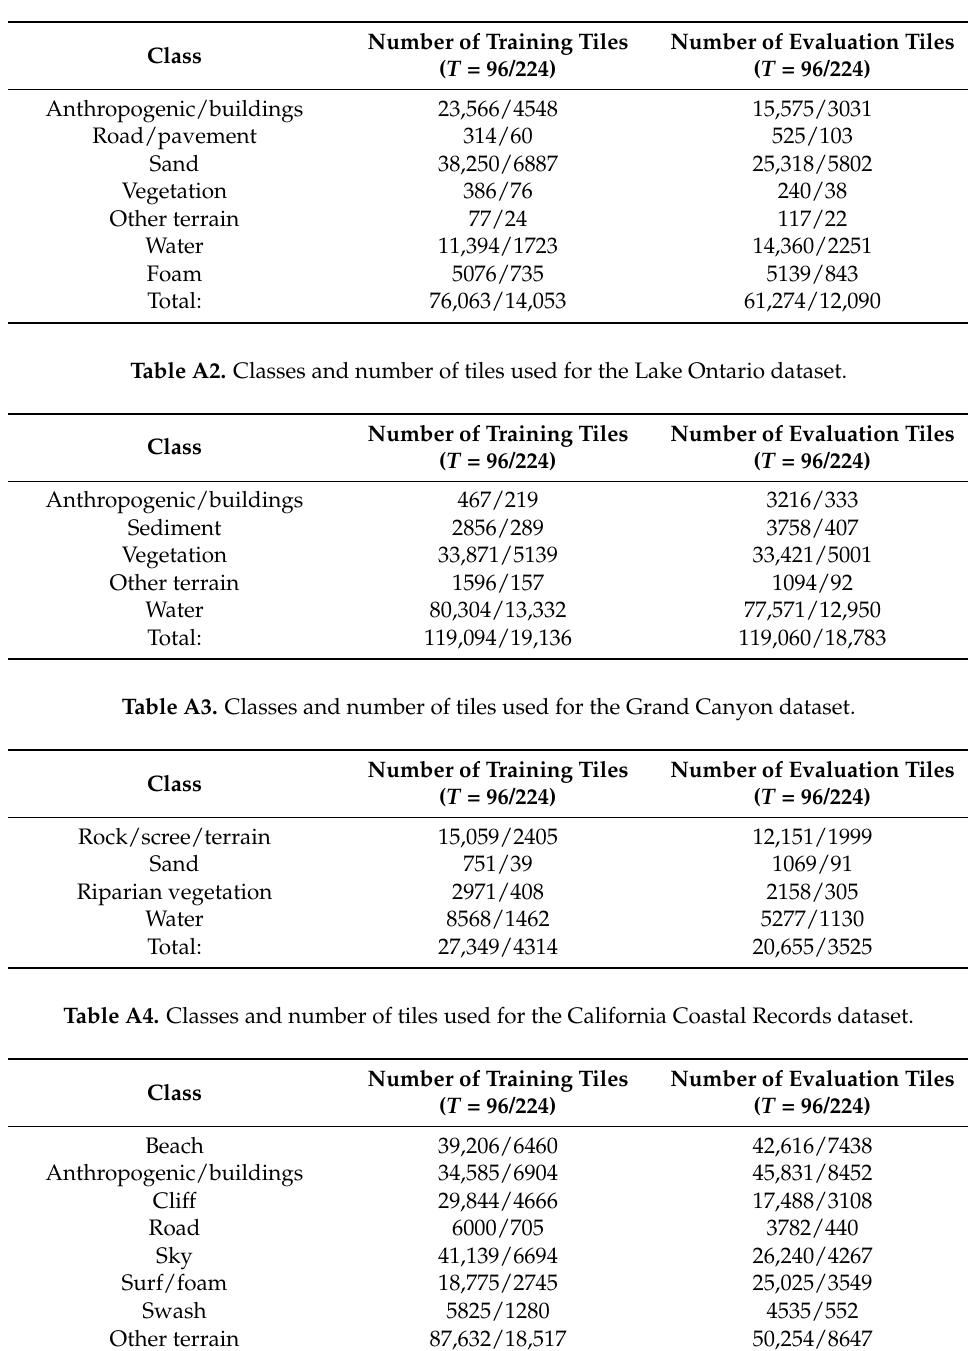
Table A1. Classes and number of tiles used for the Seabright dataset.